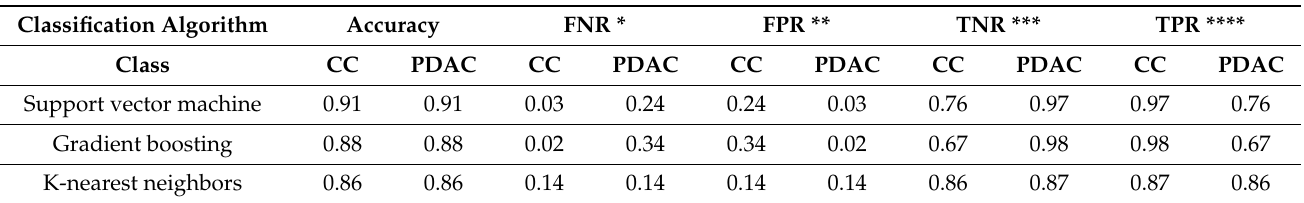
Table 2. Performance metrics for the binary classification task of differentiating between pancreatic ductal adenocarcinoma and cholangiocarcinoma using gradient boosting, support vector machine, and k-nearest neighbors on the whole